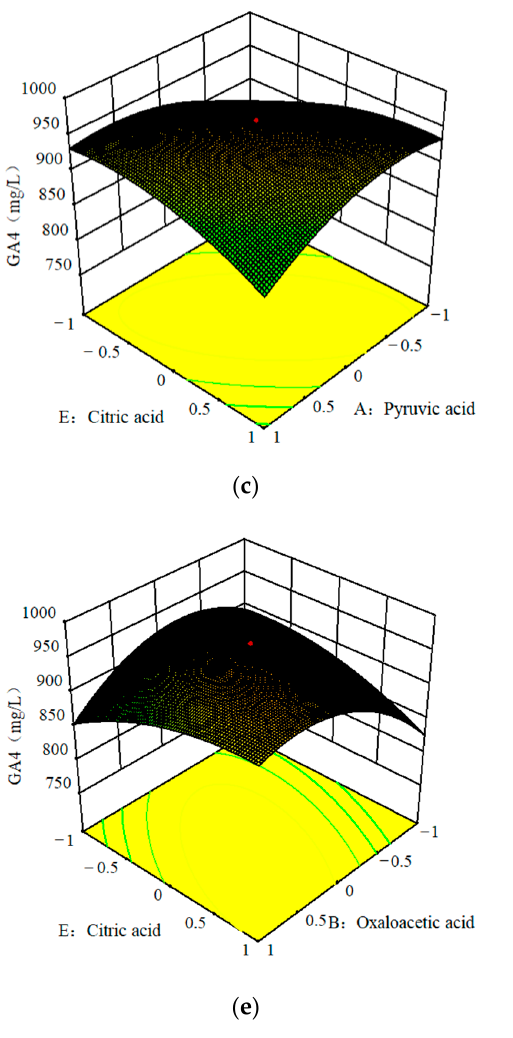
Figure 4. Three-dimensional response surface plots and corresponding two-dimensional contour plot showing the effects of variables and the interaction with GA4 production (mg/L); ( a , b ) interaction between pyruvic acid and oxaloacetic acid; ( c , d ) interaction between oxaloacetic acid and citric acid; ( e , f ) interaction between pyruvic acid and citric acid.